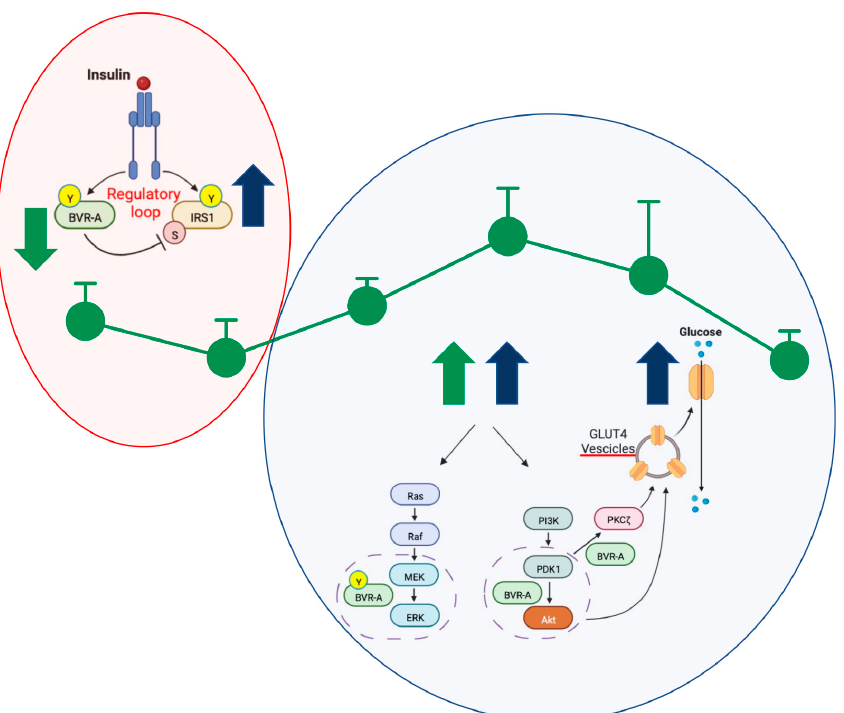
Figure 5. Proposed mechanism through which insulin promotes BVRA protein levels changes depending on the regulatory role for BVRA within the insulin signaling pathway. Upstream in the pathway (red oval) : Under physiological conditions, the insulin receptor (IR) activation promotes the phosphorylation of its direct substrate (IRS1) on specific tyrosine (Y) residues. In parallel, IR phosphorylates BVRA on specific Y residues and activates BVRA to function as S/T/Y kinase. Then, as part of a regulatory loop, BVRA phosphorylates IRS1 on inhibitory serine (S) residues (e.g., S307) to avoid IRS1 aberrant activation in response to IR. In subjects with reduced insulin sensitivity, a greater decrease in BVRA protein levels can be observed in response to insulin to favor IRS1 activation. Downstream in the pathway (blue oval): Once activated, IRS1 works as a scaffold protein, driving the activation of the two main arms of the insulin signaling: (1) the Ras/Raf/MAPK pathway (ERK1/2) mainly involved in gene transcription and (2) the PI3K/Akt axis that is critical for glucose uptake as well as for protein and lipid metabolism. Within both axes, BVRA works as a kinase or as a scaffold protein facilitating (1) the ERK1/2 phosphorylation and the subsequent translocation in the nucleus; (2) the PDK1-mediated activation of AKT; and (3) the PDK1-mediated activation of the atypical PKC ζ ; both these latter events are needed for GLUT4 translocation to the plasma membrane to increase glucose uptake. See text for more details. In subjects with reduced insulin sensitivity, a greater increase in BVRA protein levels can be observed in response to insulin to favor the activation of MAPK and AKT axes. Green arrows refer to BVRA protein levels; blue arrows refer to the molecular events regulated by BVRA.